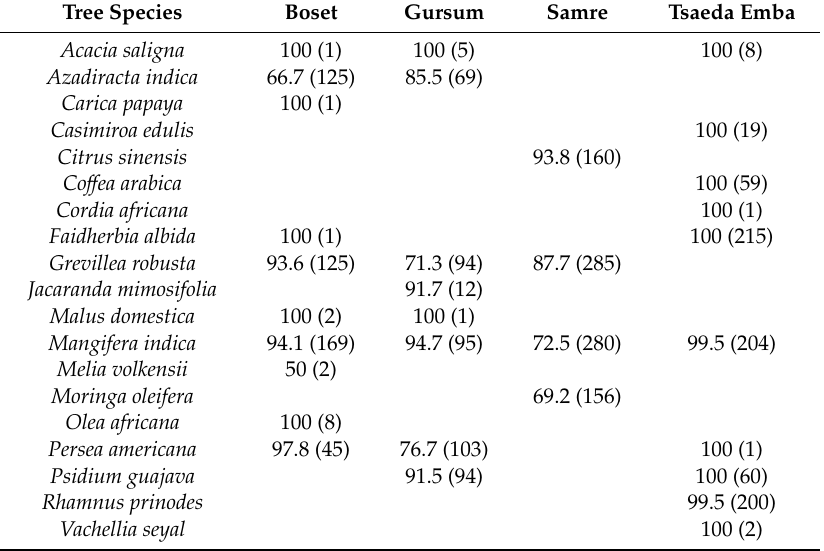
Figure 2. Boxplot of percentage tree seedling survival across the sites in Kenya (n = 7375 seedlings). The black horizontal line is the average percentage survival for each species and the gray shaded area shows the distribution of the data. Table 3. Percentage seedling survival per species in each site in Ethiopia (number of trees monitored in each species is added in